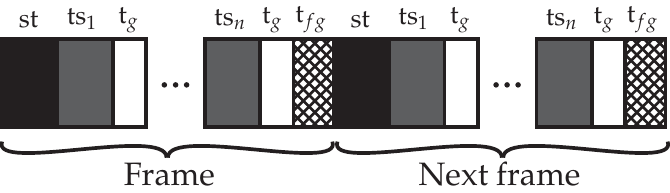
Figure 4. The TDMA frame of the implemented MAC protocol. Each time slot (ts i ) ends with the guard period (t g ). The synchronization time (st) along with the frame guard period (t fg ) are also depicted.